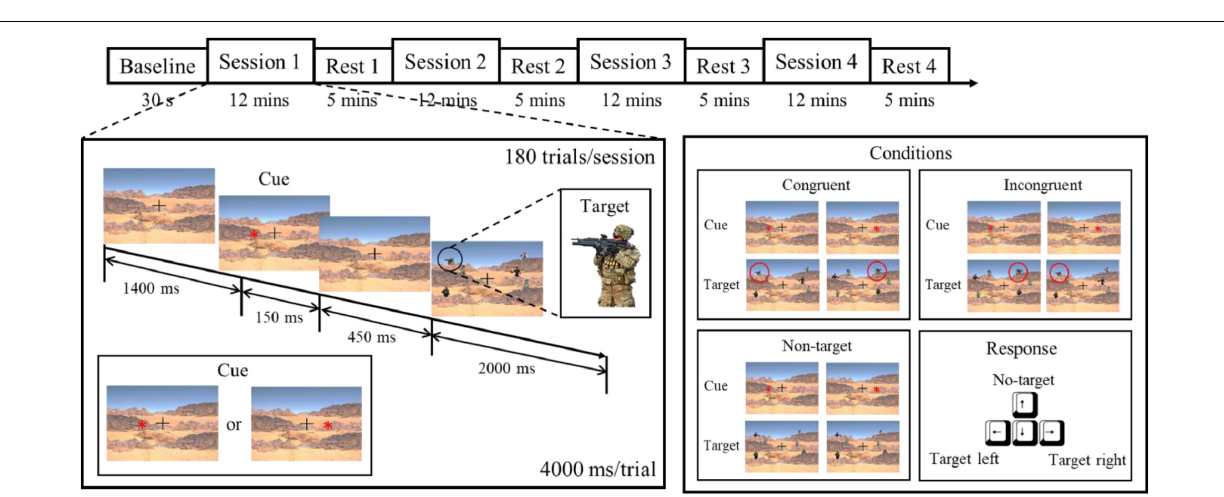
FIGURE 2 | Experimental paradigm based on target detection. The experiment was composed of five sessions and five resting periods, with each session consisting of 180 trials. Each subject was instructed to respond to the target, and the conditions of the stimulus referred to the relationship between the cue and the target (He et al., 2021). To induce the effect of fatigue, the experiment lasted about 1